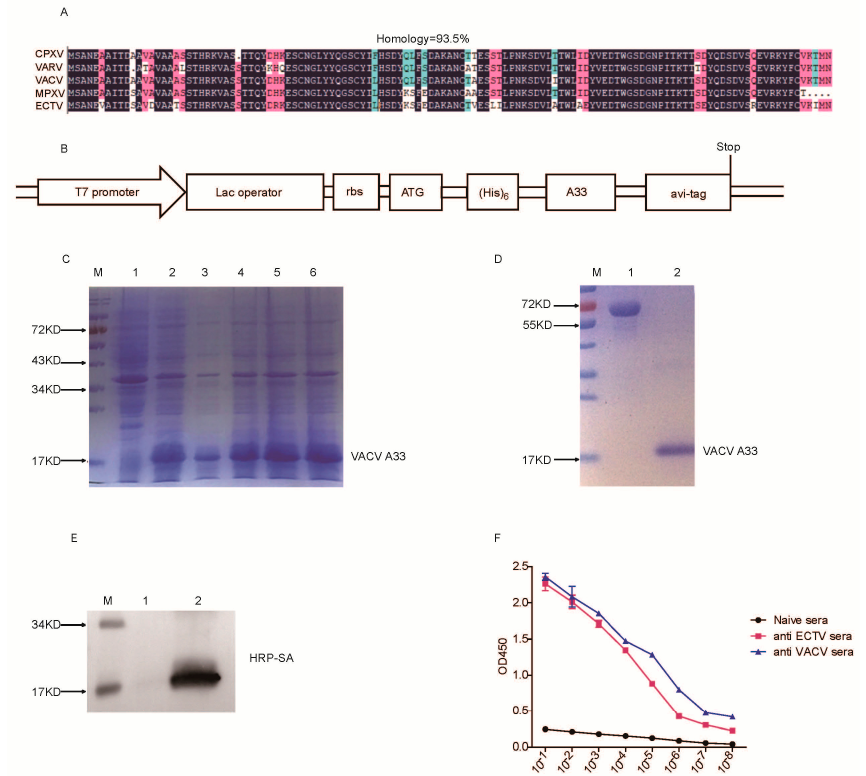
Figure 1. Production and biotinylation of A33. ( A ) DNAMAN software comparison of the homology of amino acid sequences of A33 extracellular region from VARV, VACV, MPXV, and ECTV. ( B ) Scheme of the expression vector. ( C ) Expression of A33 in BL21(DE3) cells induced with IPTG. Lane 1: control BL21(DE3) cells (vector). Lane 2, 3, 4, 5, 6: different clones of BL21(DE3) cells transfected with pET/A33. ( D ) Purification of A33. Lane 1: 1 mg/ mL BSA for comparison; Lane 2: purified and refolded A33 protein. ( E ) Western blot detection of A33 biotinylation. Lane 1: A33 protein; Lane 2: biotinylated A33 protein. ( F ) Biotinylated A33 was recognized by anti-ECTV sera and anti-VACV sera. Sera from naive mice were used as a negative control.